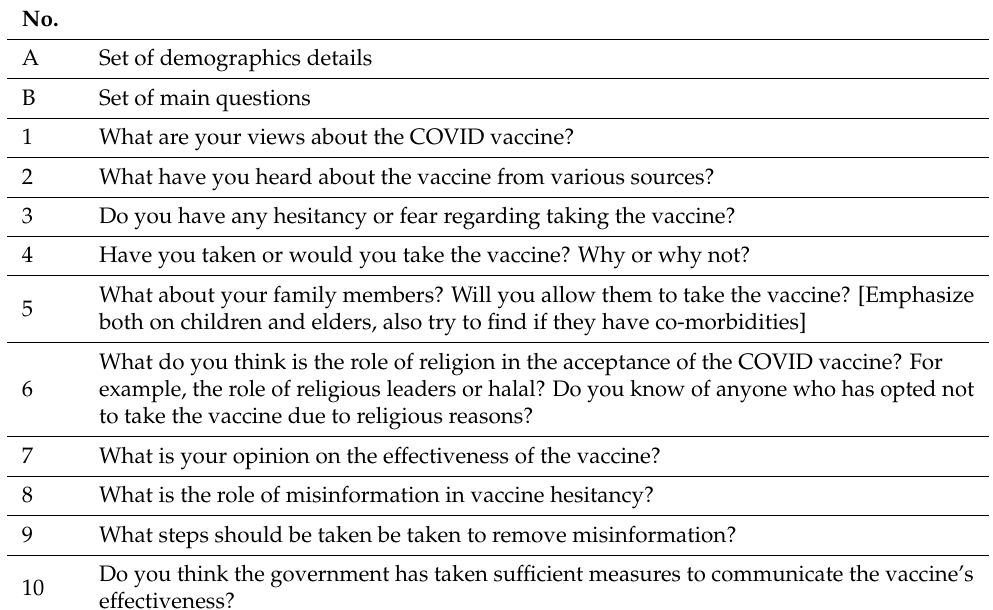
Table A1. Semi-structured interview guide for vaccine